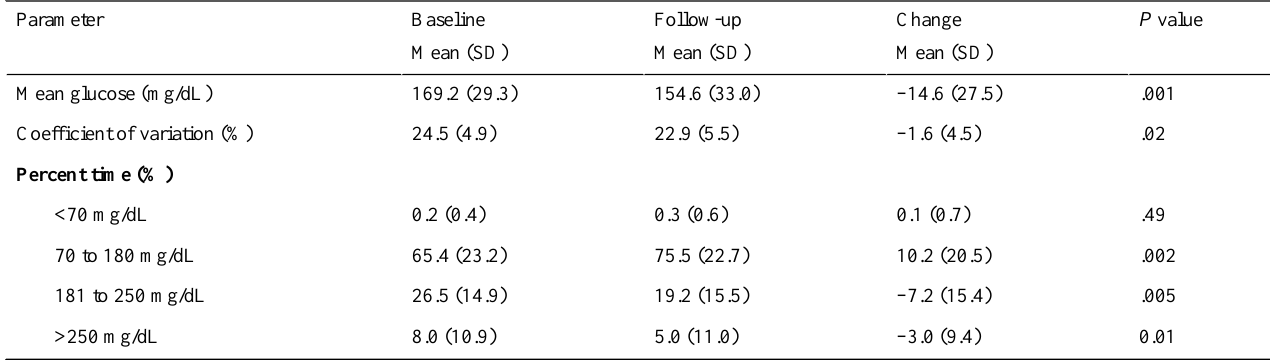
Table 2. Changes in CGM metrics at 4 months from